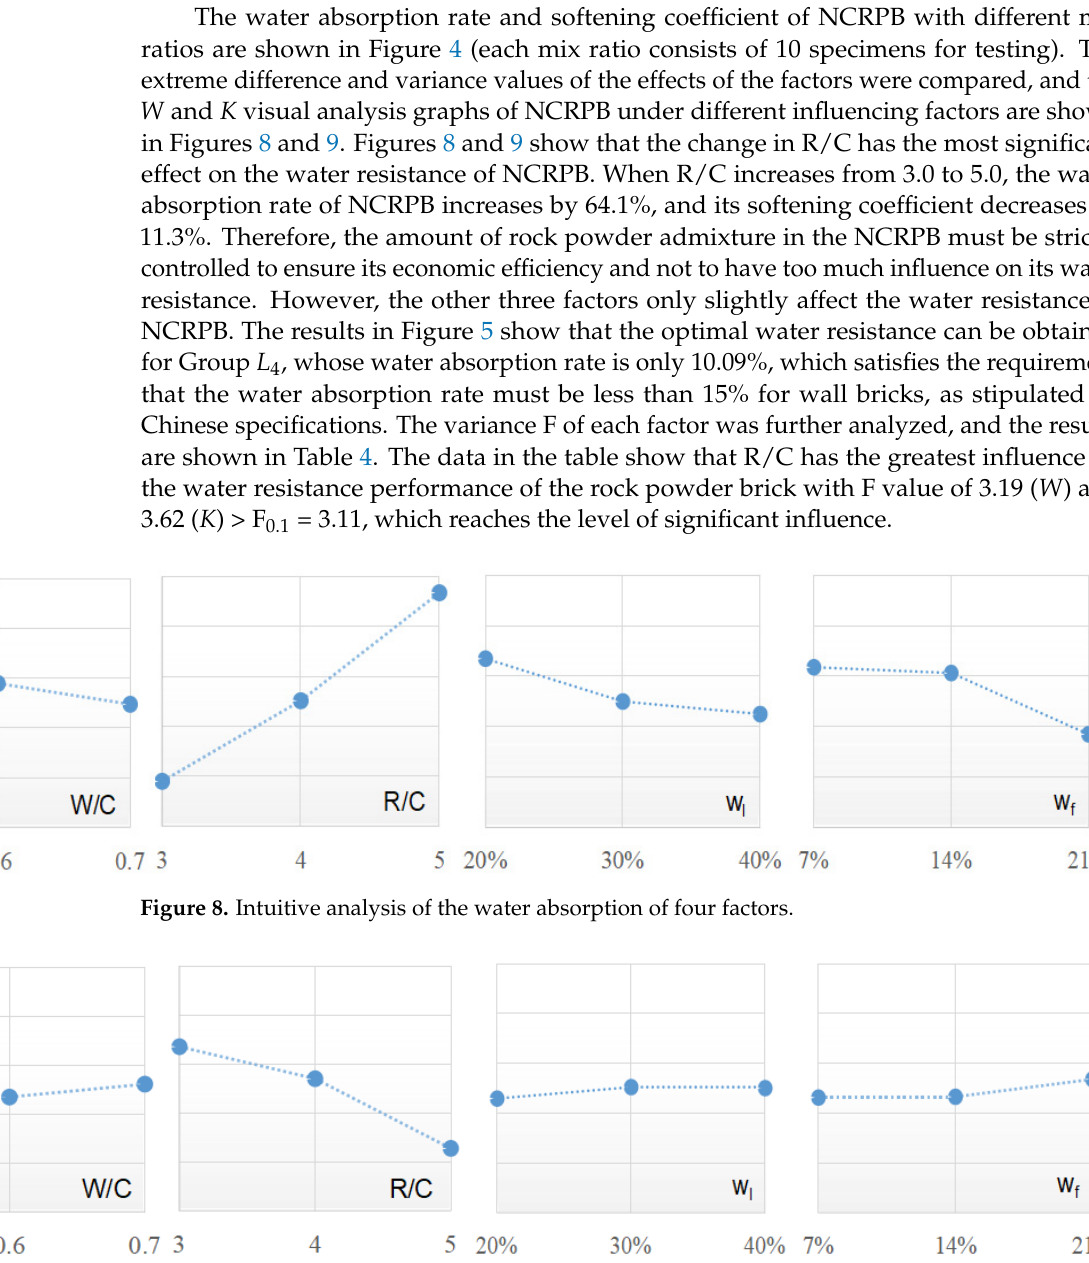
Figure 9. Intuitive analysis of the softening coefficient of four factors.